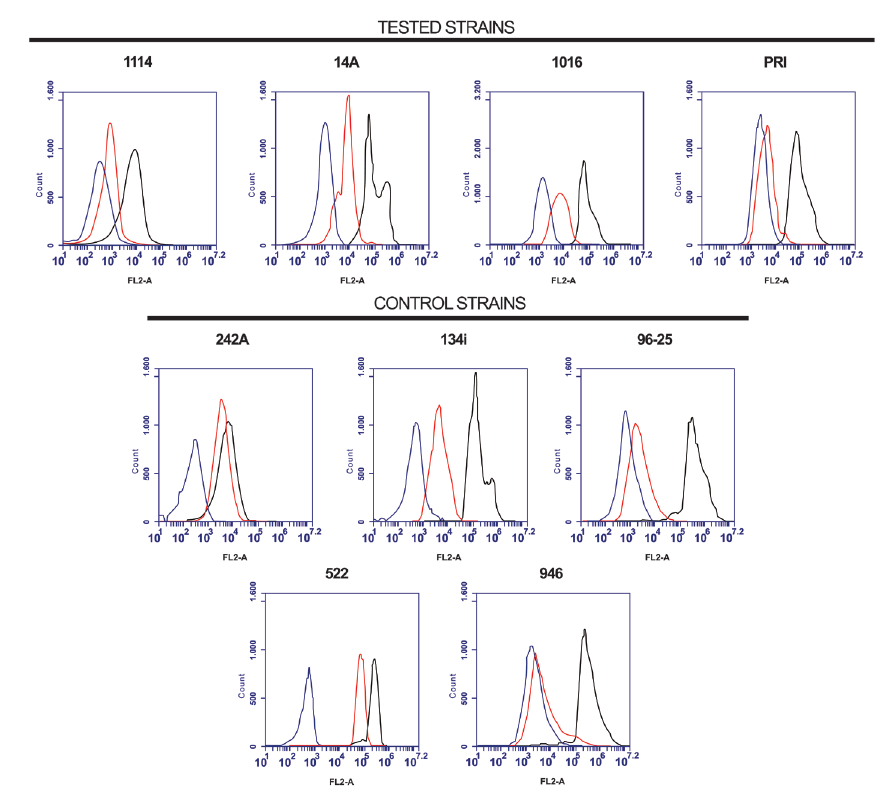
Figure 3 - Flow cytometry histograms of C. albicans isolates after treatment with nile red or rhodamine 6G. In blue: untreated cells; red: cells treated with nile red; black: cells treated with rhodamine 6G. PRI and 1114 extruded a significant amount of nile red and retained rhodamine 6G. In comparison, 1016 and 14A extruded less Nile red and retained rhodamine 6G. These results indicate the possible role of MFS transporters in these strains resistance and suggest a secondary mechanism of resistance for 1016 and 14A. Results are representative of at least four independent